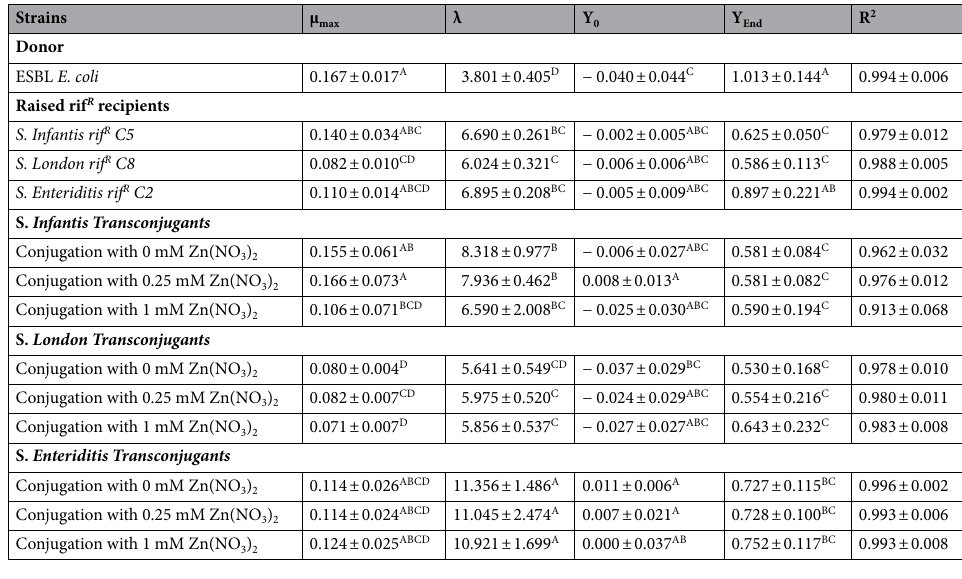
Table 2. Growth curve parameters of fitted Gompertz models of donor, recipients, and transconjugants, with µ and the Tukey post-hoc test with α = 0.05. Groups that differ significantly for each fitted parameter are denoted by different superscripts.